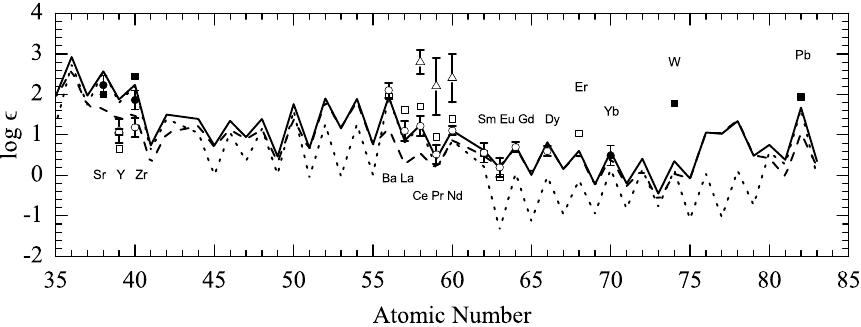
Fig. 24. The abundance pattern of neutron-capture elements in the atmosphere of HD 209621. The final mean abundances calculated using neutral (filled circles) and ionized (open circles) lines are given along with the scaled solar system abundance (solid line), solar s-process (dotted line) and r-process (dashed line) components according to Burris et al. (2000). The abundances derived by Vanture (1992b) and Goswami & Aoki (2010) are shown by triangles and